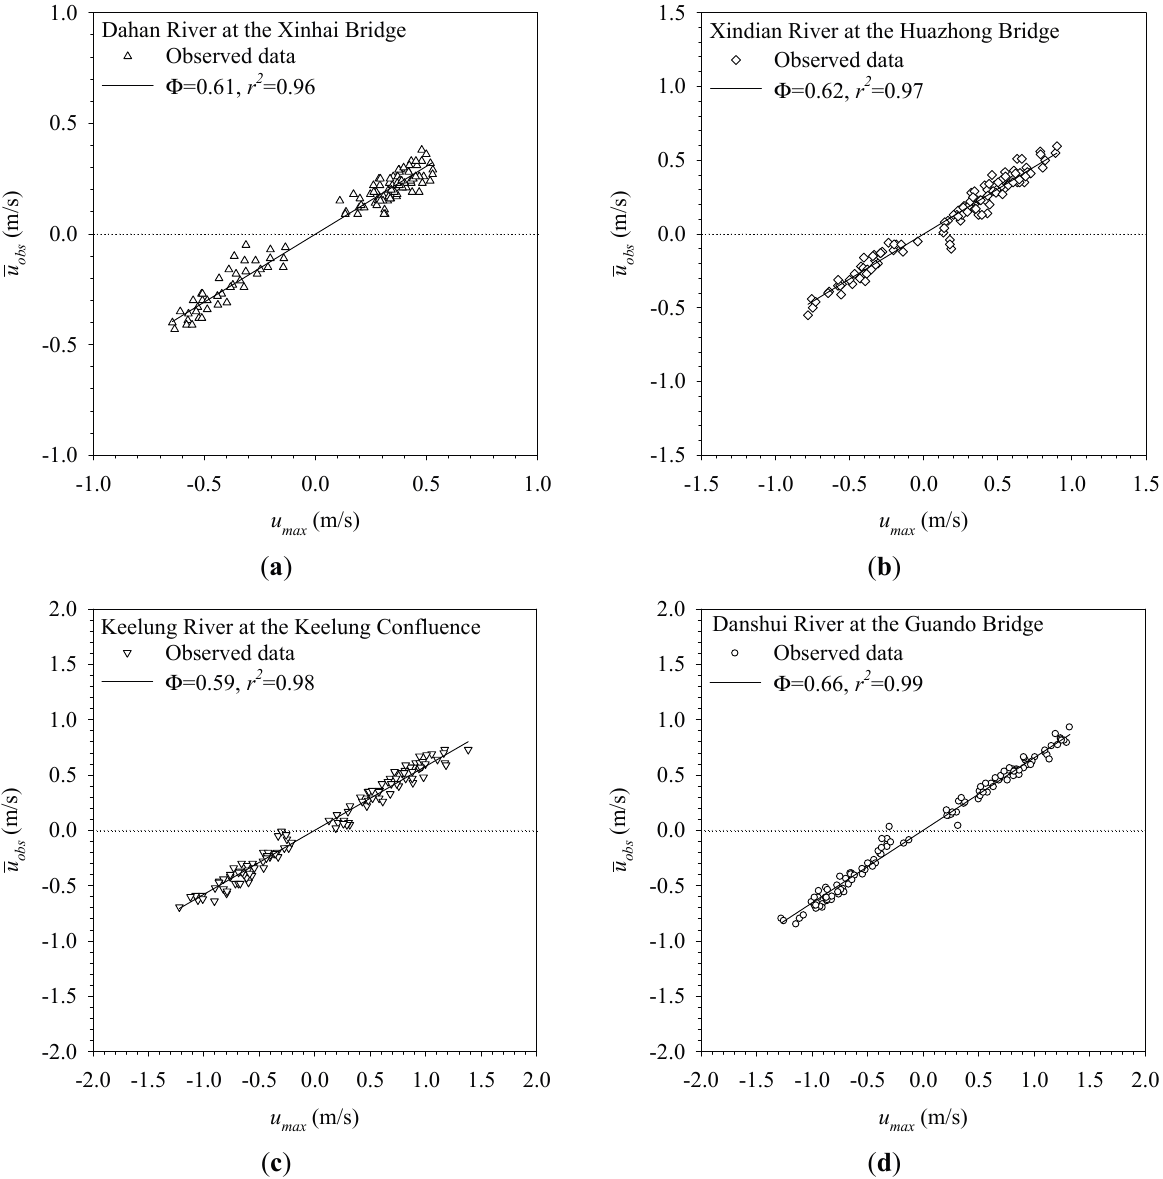
The relationship between the water level and cross-sectional area for each gauging station is shown in Figure 5. At Xinhai Bridge, Huazhong Bridge, Keelung Confluence and Guando Bridge, the cross-sectional area can be determined as 175.61( G + 2.54) 1.02 , 37.91( G – 0.66) 1.52 , 167( G + 2.77) 0.89 and 28.39( G + 4.88) 1.92 , respectively. It can be seen that the rating curves are very close to the scatter data. No significant deviation is observed. The results show that the stage-area rating curve is robust in